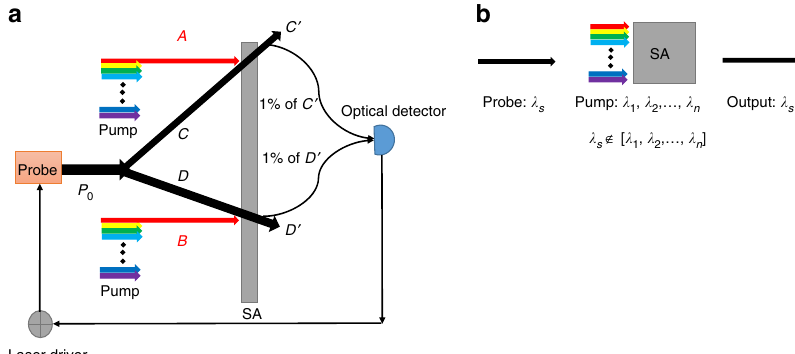
Fig. 5 Normalization and wavelength remapping. a Schematic setup to normalize two numbers using a pump-probe saturation experiment. b Wavelength remapping concept where each element of the probability vector is modulated in the presence of a broadband pump, requiring spatial separation in the saturable absorber